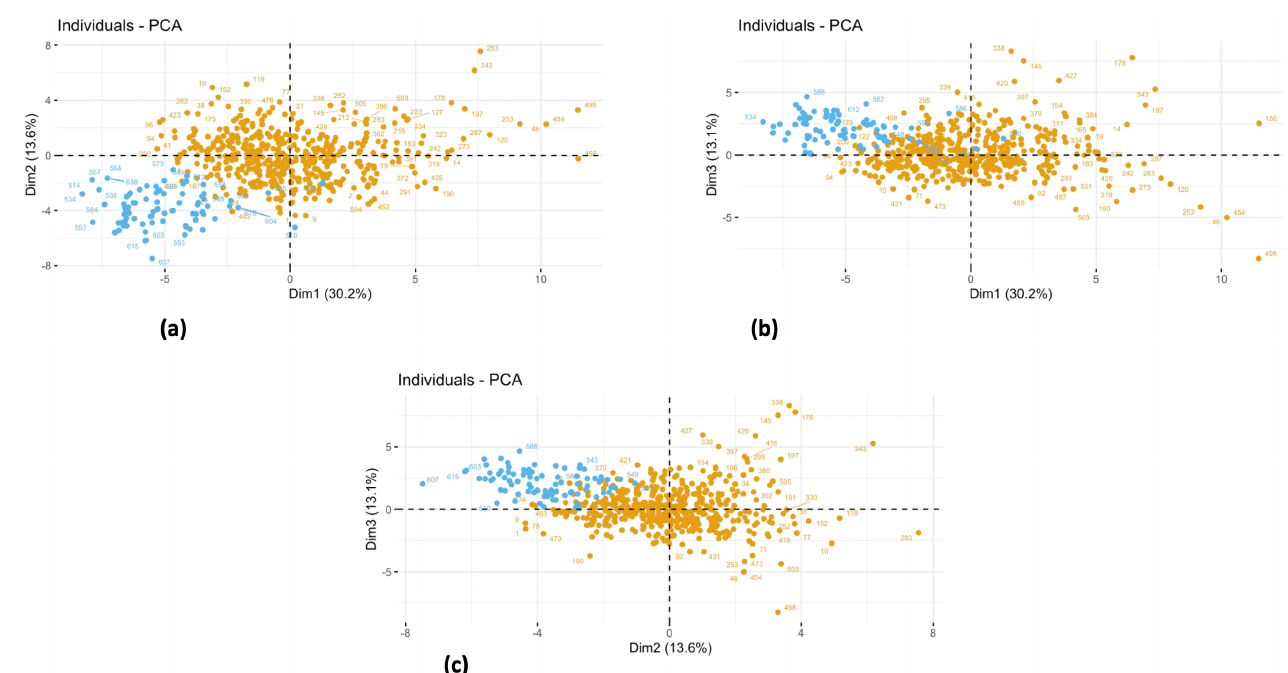
Figure 2. In this panels, the obesity (OB) observations (orange points) are projected in the subspaces defined by the first three principal components that explained the most variability in the dataset. The NW (light blue points) are passively projected in the subspaces. As can be observed in figure ( a – c ), the NW observations clustered in a region of the space where PC1 is negative.